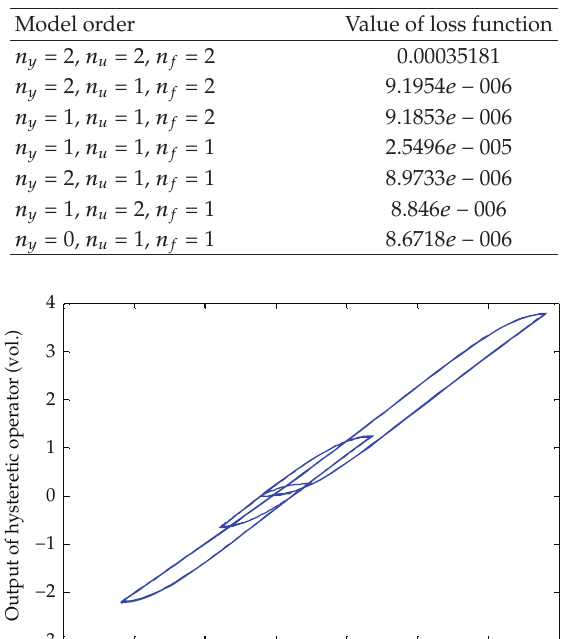
Table 1: Model order selection.